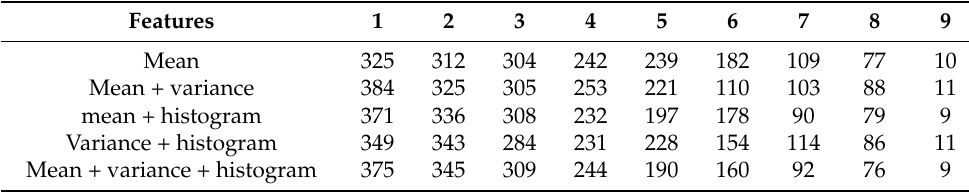
Table 3. K = 9 number of images in each cluster.